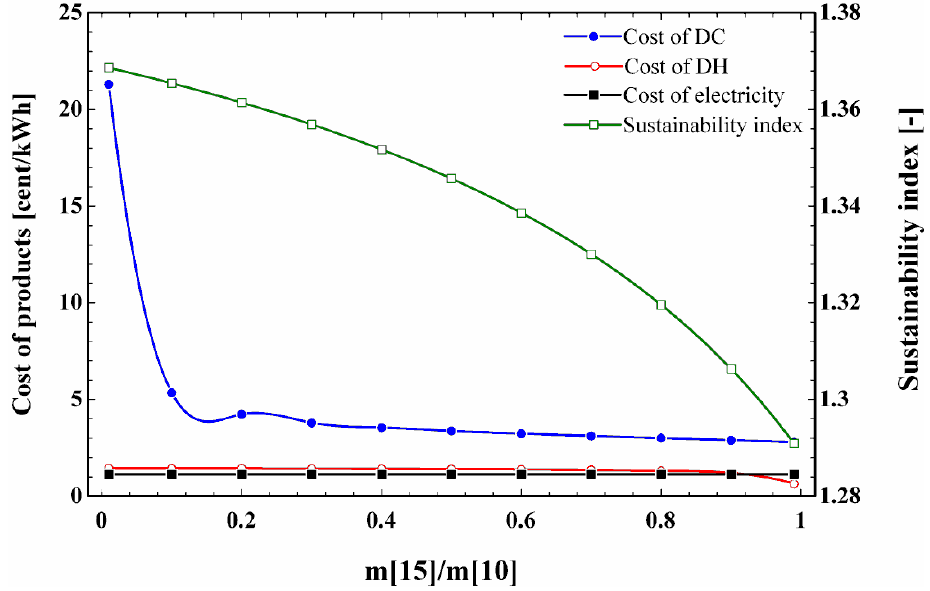
Figure 5. Effect of the chiller supply on the system performance Figure 5. E ff ect of the chiller supply on the system